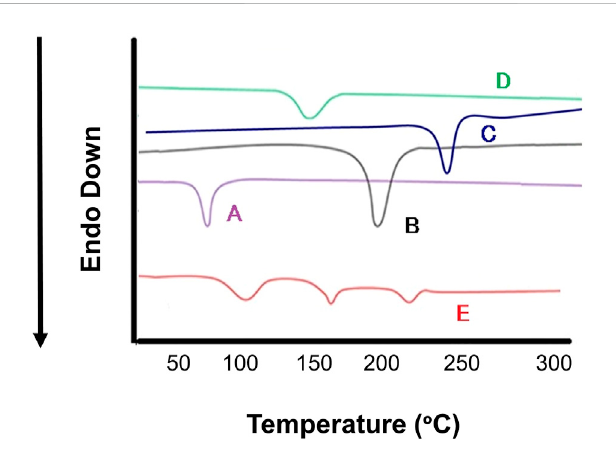
FIGURE 8 Differential scanning calorimetry (DSC) thermogram of (A) Stearic Acid (B) Doxorubicin, (C) Ethyl Cellulosecellulose, (D) Oleic Acid (E)